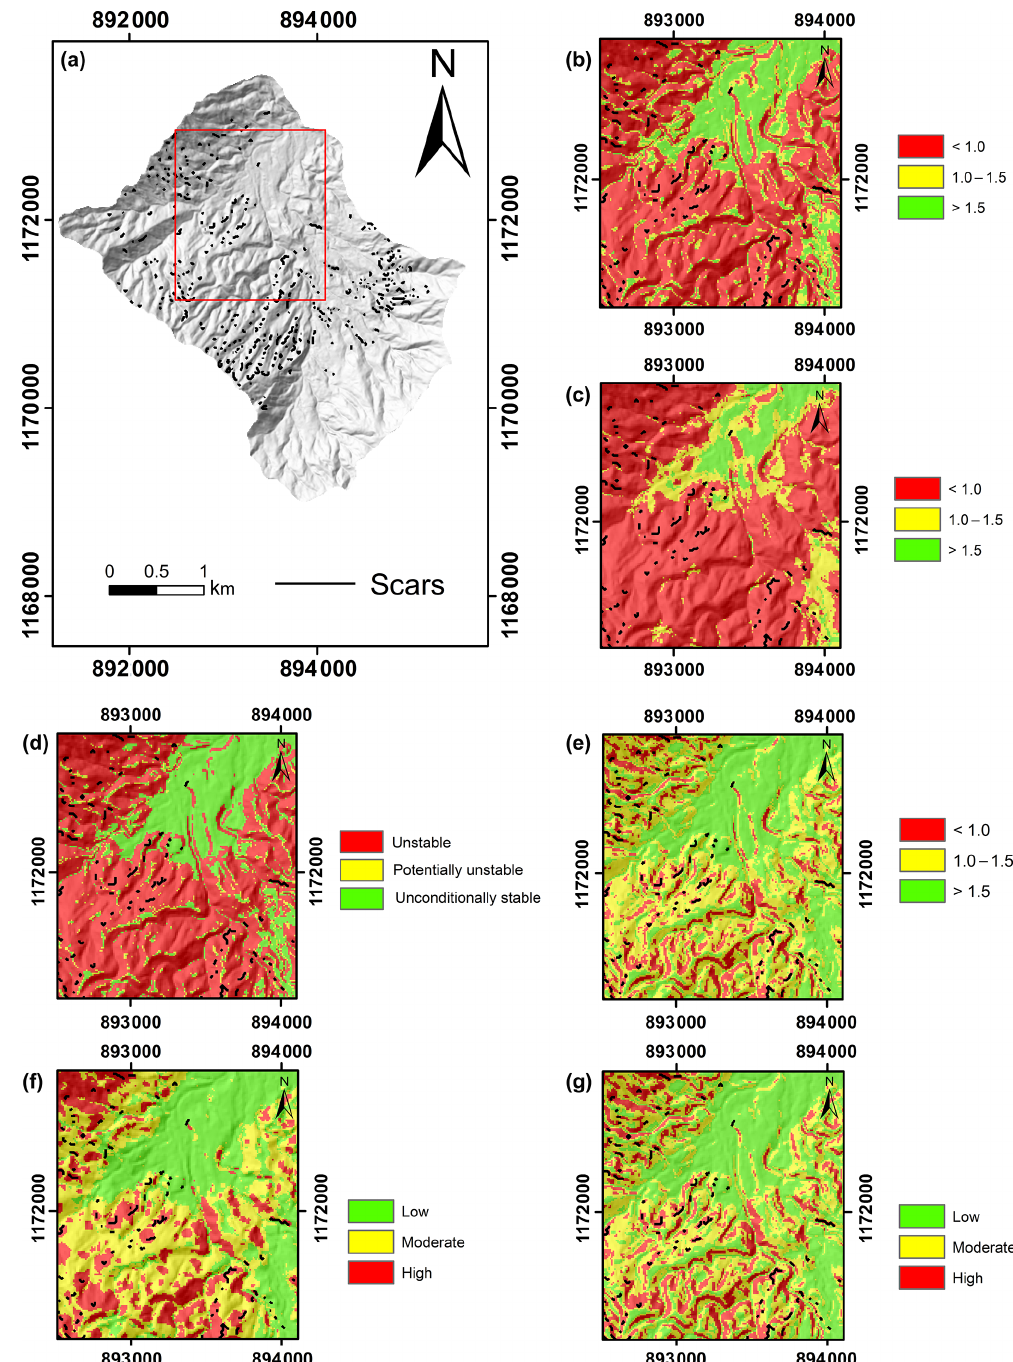
Figure 6. Comparison of results. (a) Analysis area. (b) FoS obtained with r.slope.stability (infinite slope stability model). (c) FoS obtained with r.slope.stability (slip surface model). (d) Analysis with SHALSTAB (Aristizábal et al., 2015). (e) FoS obtained with SHIA_Landslide (Aristizábal et al., 2016). (f) P f obtained with r.slope.stability (ellipsoid-based model). (g) P f obtained with r.slope.stability (infinite slope stability